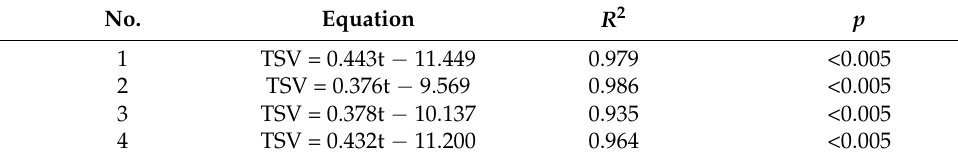
Table 4. Approximate curve equations.